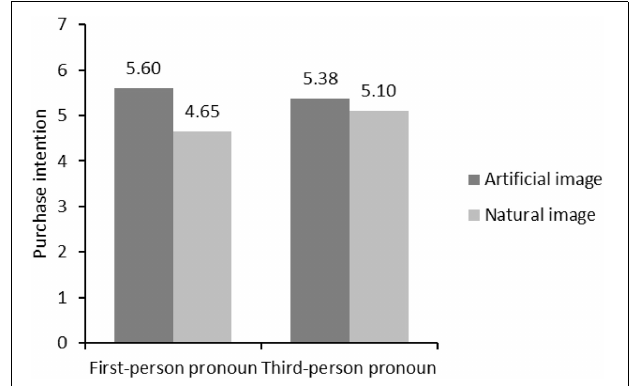
FIGURE 3 | The purchase intentions of different